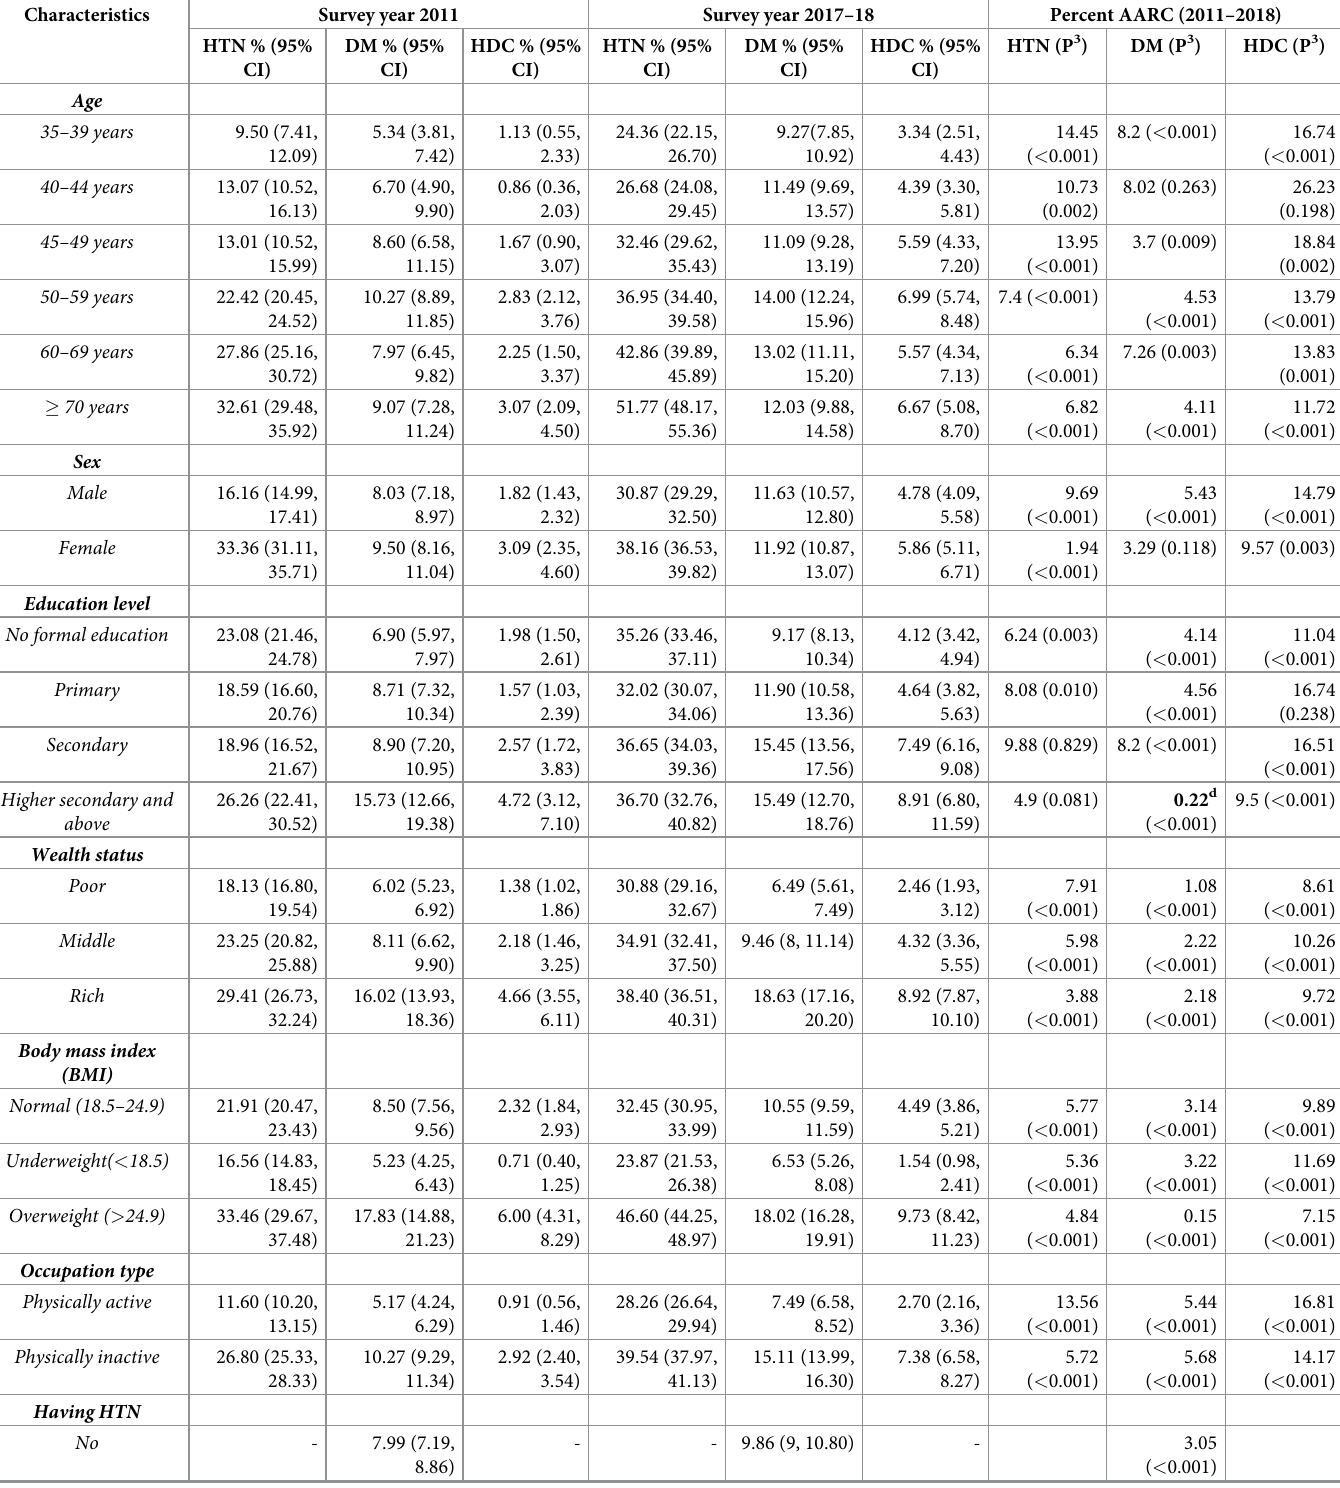
Table 1. The average annual rate of change of HTN, DM, and HDC prevalence among baseline characteristics in Bangladesh by year of survey.